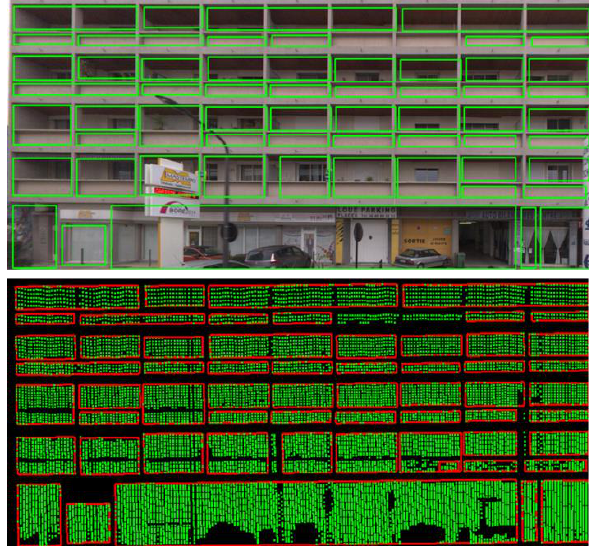
Figure 10: Failure example. Top: detected openings overlaid on the texture image. Bottom: detected opening points (green) and openings contours (red). The ground floor and the walls of the loggias are not in the same plane as the main wall.